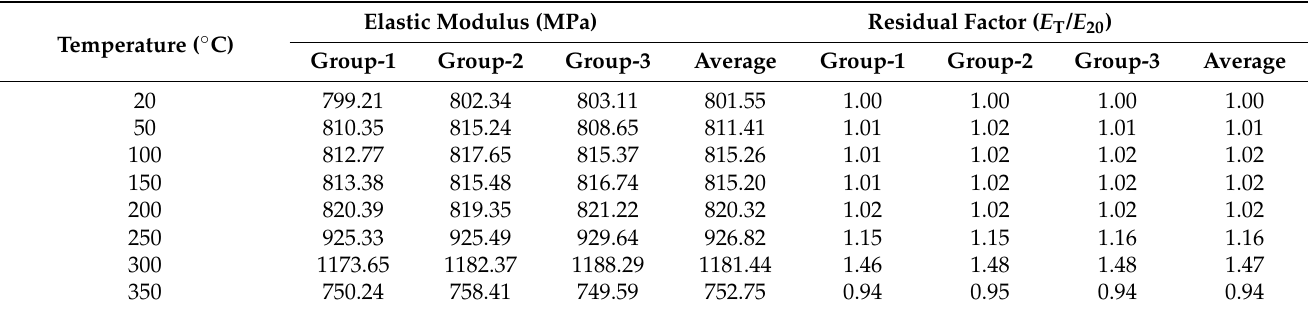
Table 5. Elastic moduli and residual factors of FRP composites at elevated